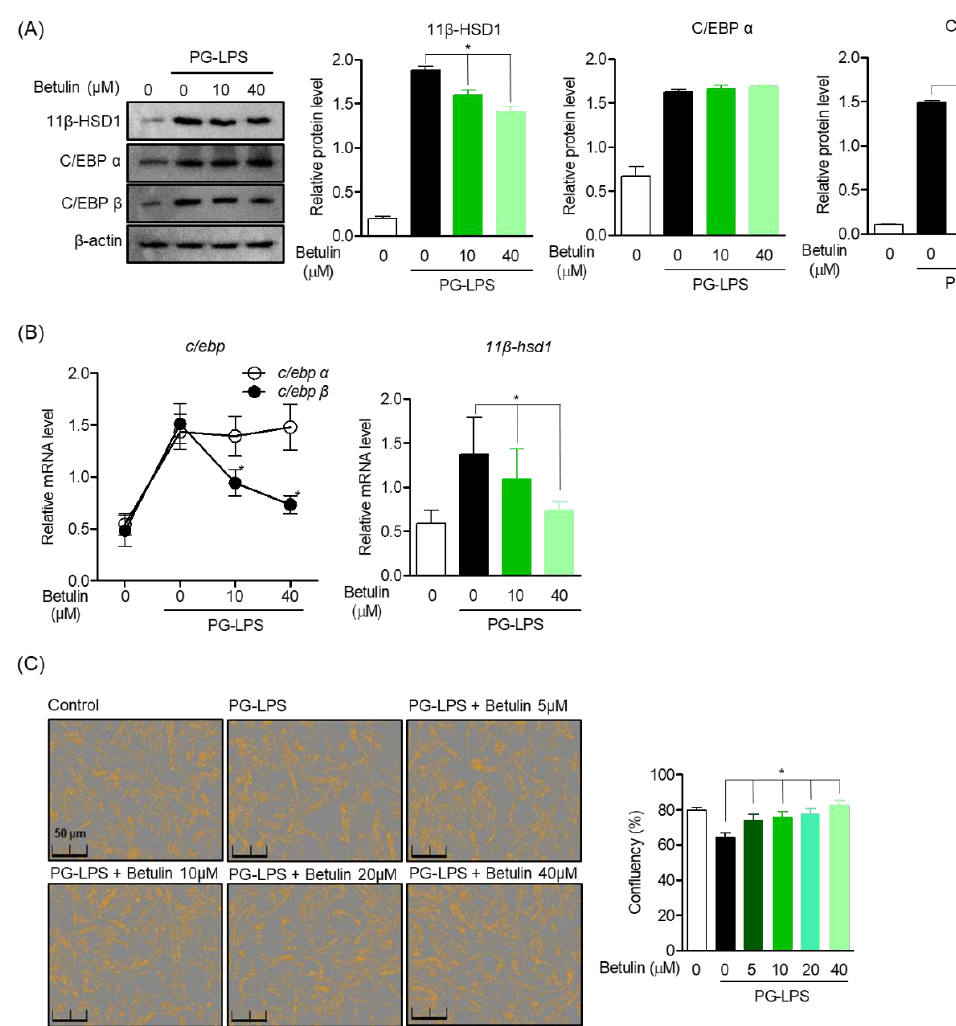
Figure 3. Effect of Betulin on C/EBP and 11β -HSD1 Activity Regulation in PG-LPS Stimulated HPDL Cells. The cells (1 × 10 6 cells/mL) were pre-treated with 10 and 40 µ M for the 6 h then after, PG-LPS (1 μg/mL) was treated for the 24 h. The expression of each proteins ( A ) and gene level ( B ) were analyzed by Western blot and real time pcr. The cell confluents were analyzed using the Incucyte ® Live-Cell assay system to marked the cell confluency of normal cells ( C ). * p < 0.05 was considered significant differences between each treated groups.